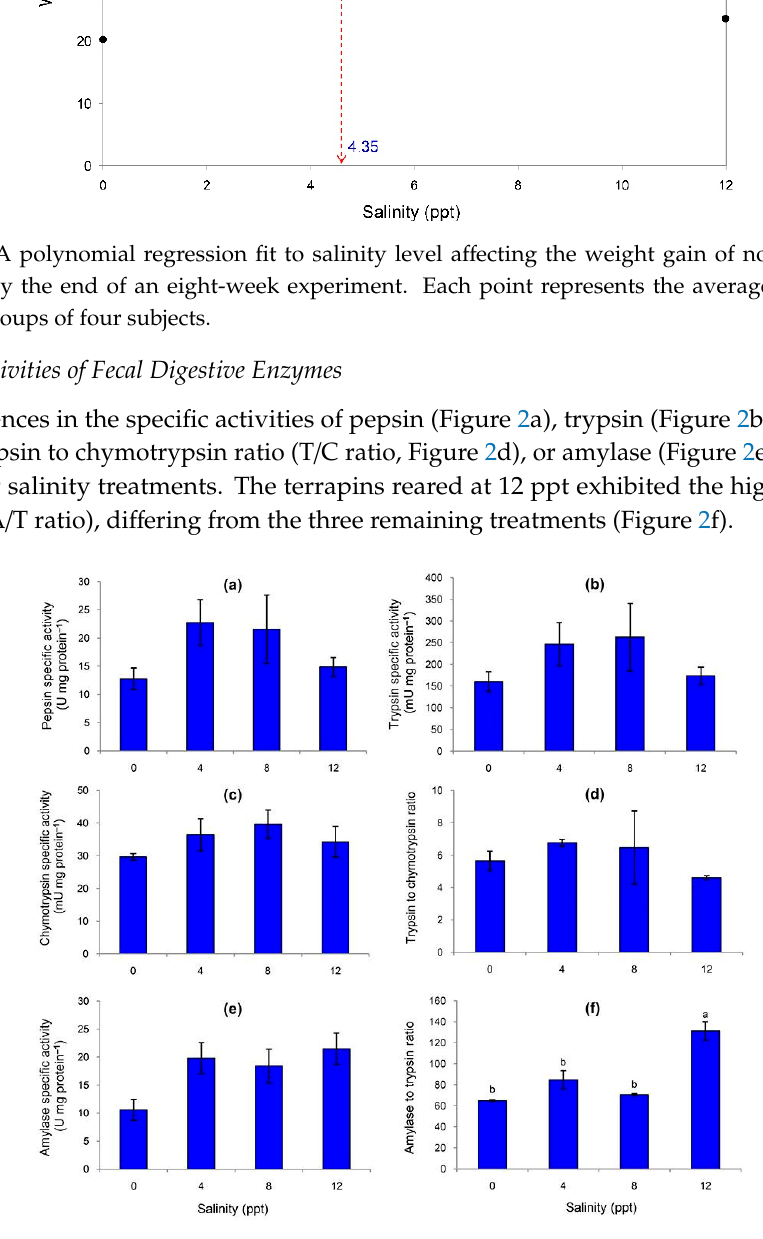
Figure 2. Specific activities of fecal digestive enzymes in northern river terrapins reared in various salinities: pepsin ( a ), trypsin ( b ), chymotrypsin ( c ), trypsin to chymotrypsin ratio ( d ), amylase ( e ), and amylase to trypsin ratio ( f ). The feces were sampled at the end of the eight-week experiment. Data are expressed as mean ± SEM ( n = 3 per treatment). Different superscripts (a and b) indicate a significant difference ( p < 0.05).